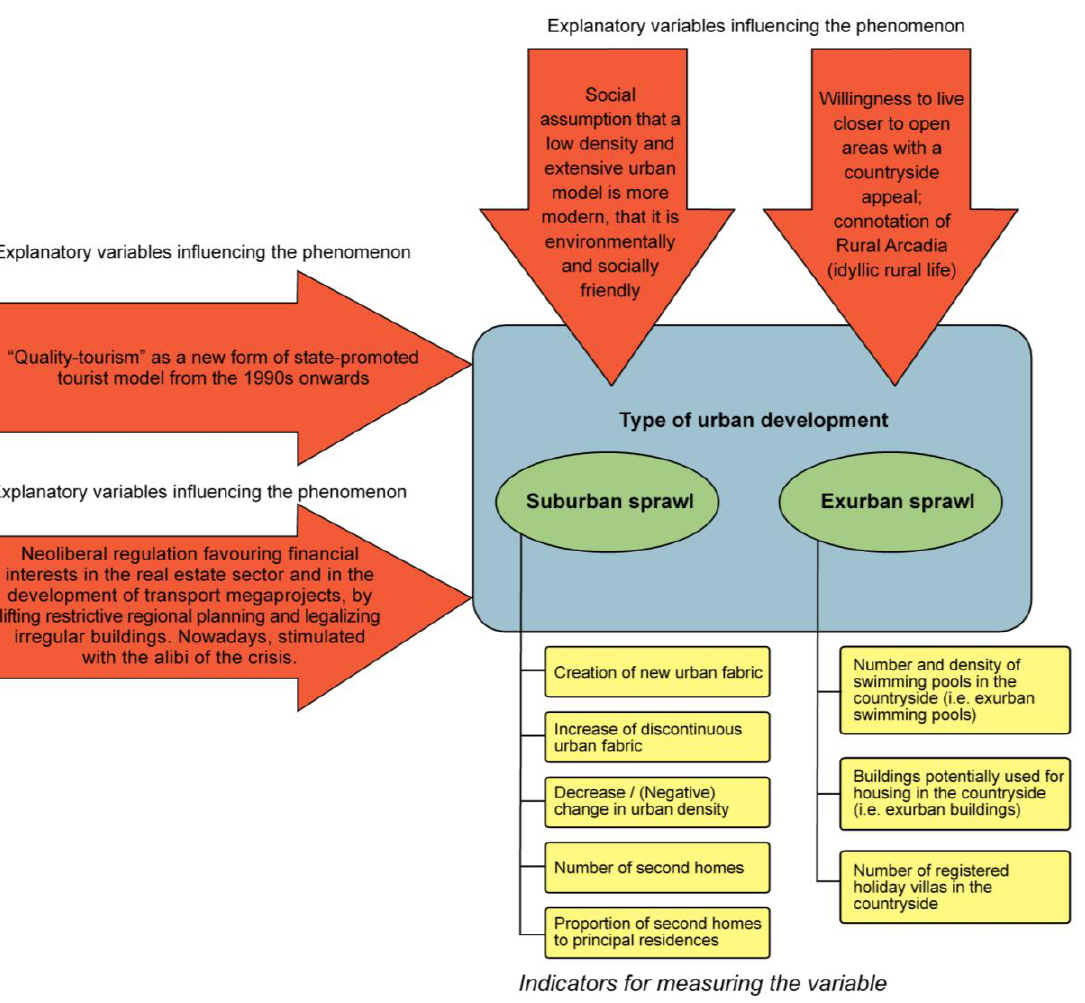
Figure 3. Scheme of the empirical approach to analyze the types of development (suburban and exurban sprawl), showing the explanatory variables and the indicators by which the variables are